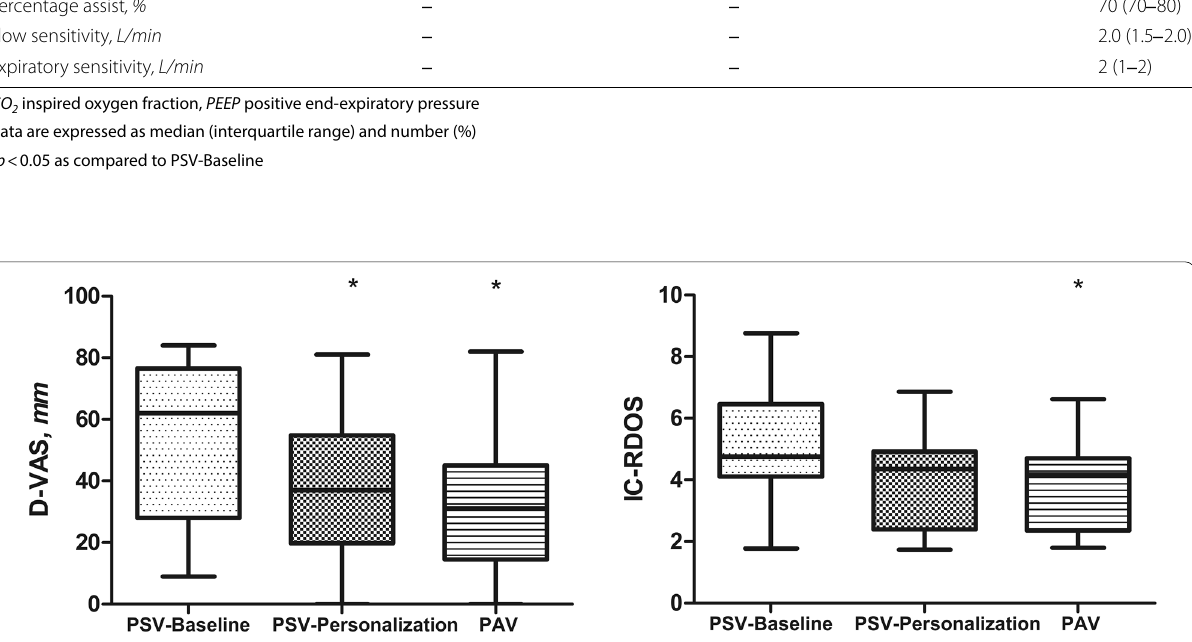
Fig. 1 Dyspnea visual analog scale (D‑VAS) and Intensive Care‑Respiratory Distress Observation Scale (IC‑RDOS) at baseline (PSV‑Baseline), after personalization of ventilator settings (PSV‑Personalization) and with proportional assist ventilation (PAV). Line inside the boxes median, limits of the boxes 75th and 25th percentiles of the data (interquartile range), whiskers 5th and 95th percentiles. * p < 0.05 compared to